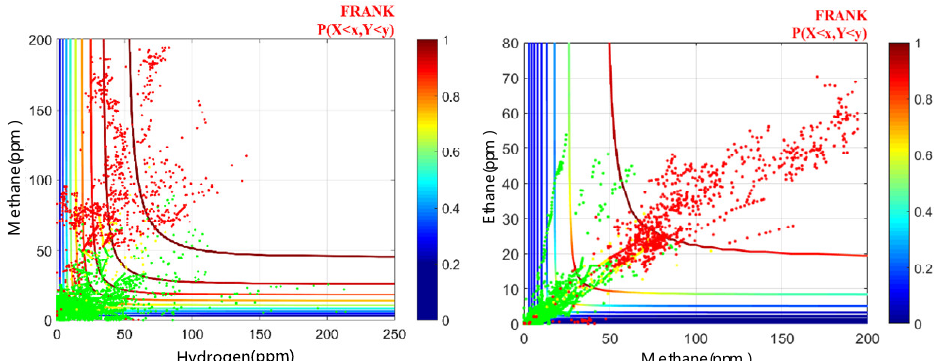
Figure 2. Copula joint distribution of different variable combinations (Methane vs. Hydrogen, Methane vs. Ethane).